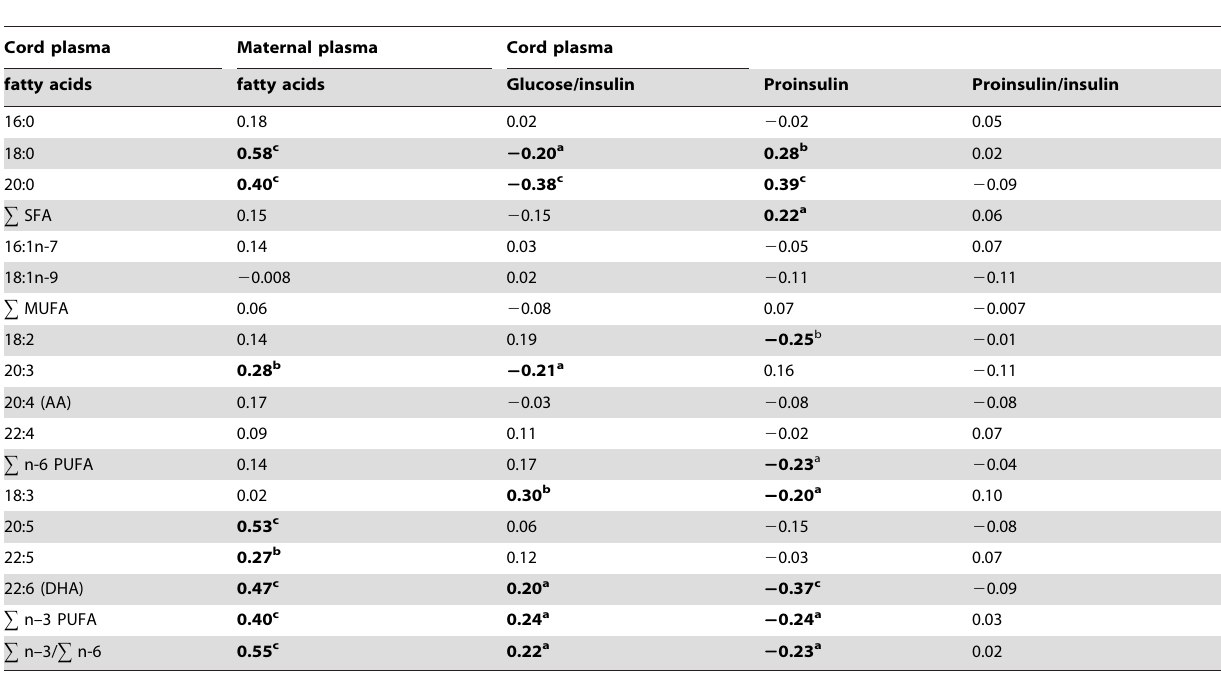
Table 3. Partial correlations between maternal and fetal/cord plasma fatty acids and between cord plasma fatty acids and indicators of fetal insulin sensitivity and beta-cell function*.